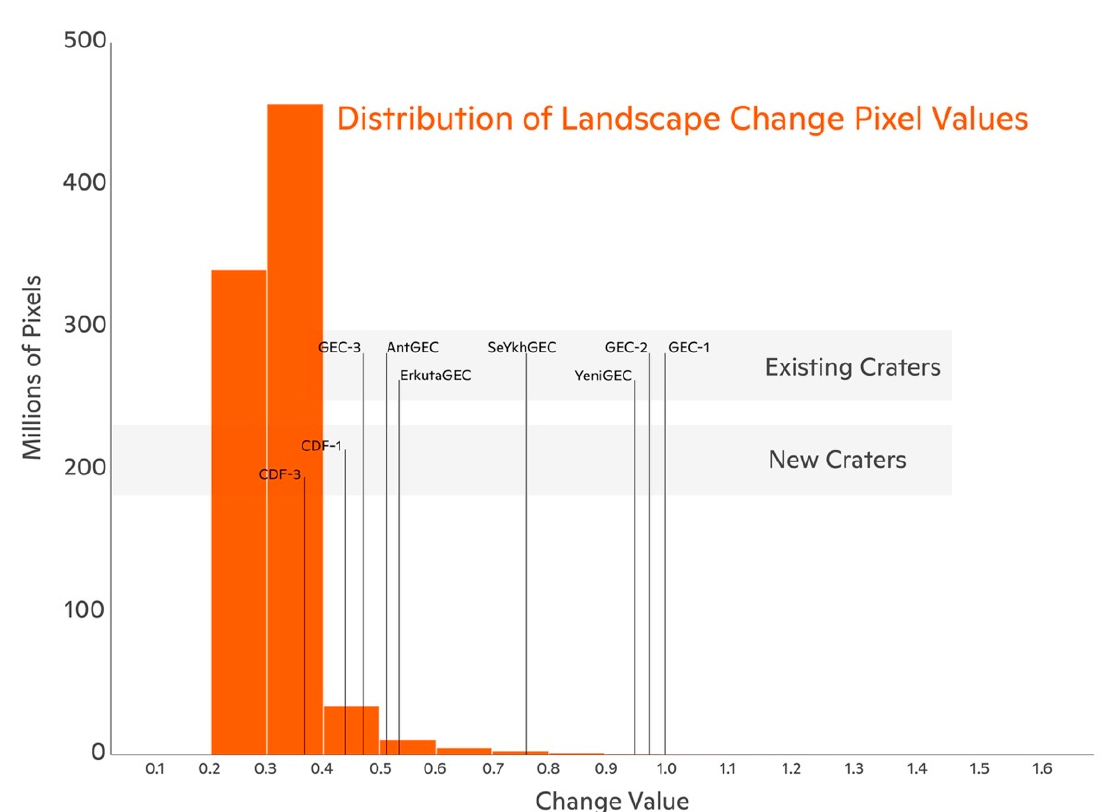
Figure 4. Distribution of surface change pixel values (range = 0.098–1.62, n = 1.9 × 10 9 ). Vertical lines connect change pixel values with corresponding GECs. CDF-2 is not shown because its land surface change values were omitted by the water mask.